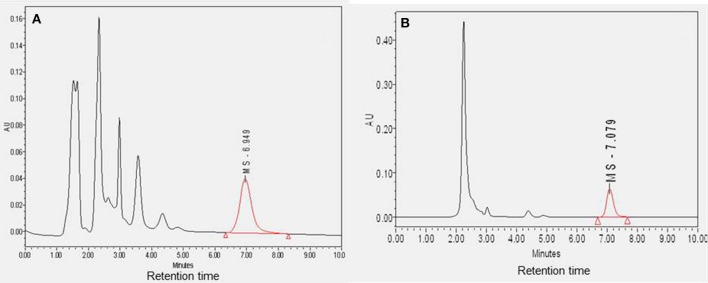
Diagram showing the sample chromatograms of MS-153 in plasma (A) and CSF (B) (n = 4). The X-axis represents the retention time of MS-153 in minutes and the Y-axis represents the absorbance of MS-153 in absorbance units.